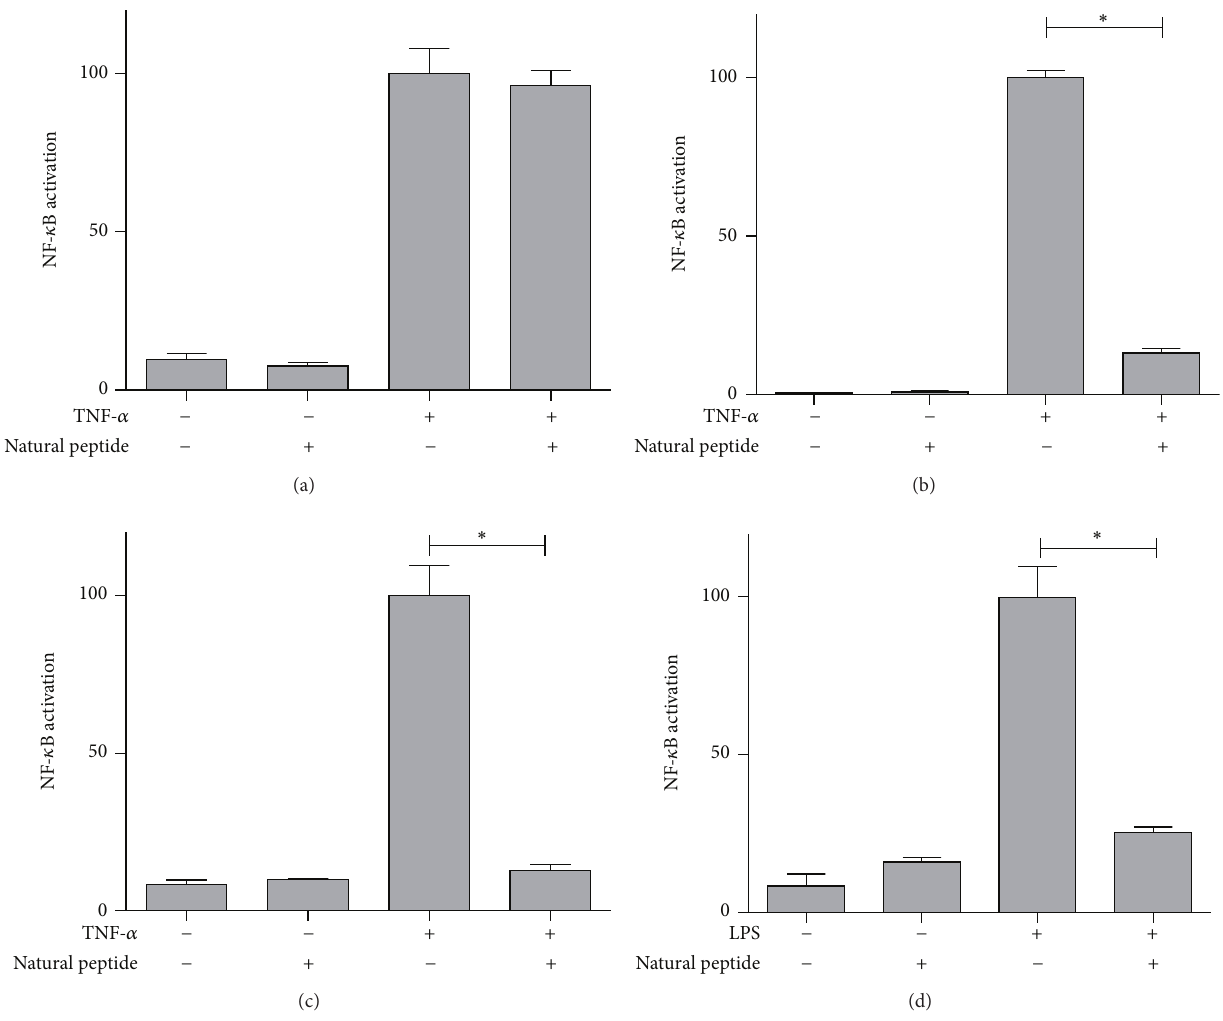
Figure 8: Natural cyclic peptide effect on NF- 𝜅 B activation induced by TNF- 𝛼 and LPS on Caco-2-NF- 𝜅 B-hrGFP C3 and HT-29-NF- 𝜅 B- hrGFP E5 and F6 clones cells. The natural cyclic peptide was added to Caco-2-NF- 𝜅 B-hrGFP C3 clone (a) and HT-29-NF- 𝜅 B-hrGFP E5 (b) and F6 ((c), (d)) clones simultaneously with TNF- 𝛼 ((a), (b), and (c)) or LPS (d), respectively. For HT-29-NF- 𝜅 B-hrGFP clones, 1ng/mL TNF- 𝛼 or 5 ng/mL LPS was employed, while for Caco-2-NF- 𝜅 B-hrGFP C3 clone 5ng/mL TNF- 𝛼 was used. After 48 h for Caco-2-NF- 𝜅 B- hrGFP clone and 18–24 h for HT-29-NF- 𝜅 B-hrGFP clones, NF- 𝜅 B activation (measured by the percentage of GFP + cells) was analyzed by flow cytometry. Cell viability was over 90% for all tested conditions. Data was normalized against TNF- 𝛼 or LPS controls (considered as 100%) and shown as the mean ± SD of triplicates of a representative experiment. ∗ 𝑃 < 0.05 using One-Way ANOVA with Dunnett’s